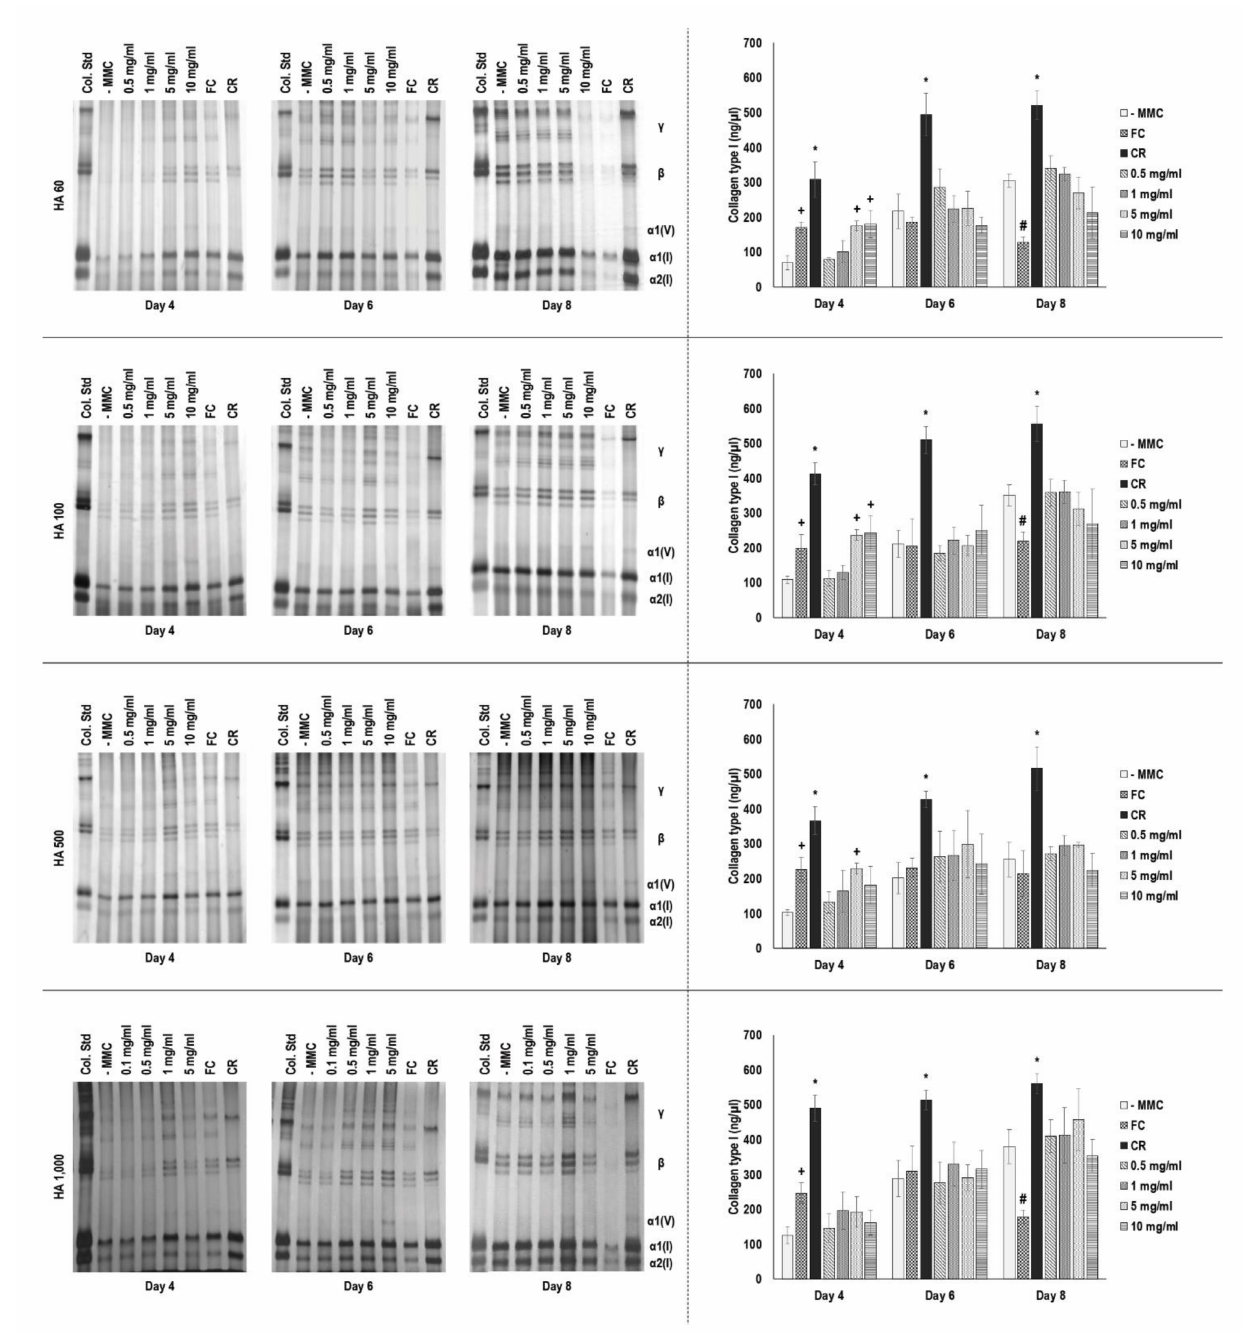
Figure 1. SDS-PAGE and complementary densitometry analyses revealed that carrageenan induced the highest ( p < 0.05) collagen type I deposition at all timepoints. * indicates significantly ( p < 0.05) higher deposition among all groups at a given timepoint. + indicates significantly ( p < 0.05) higher deposition than the non-macromolecular crowding (MMC) control group at a given timepoint. # indicates significantly ( p < 0.05) lower deposition than the non-MMC control group at a given